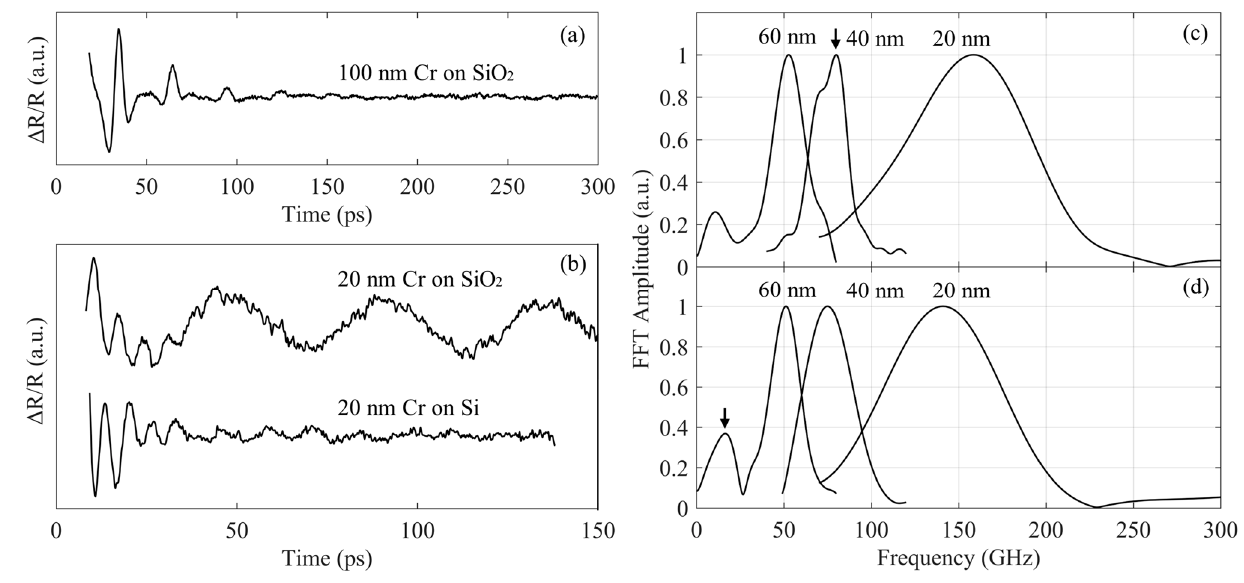
Figure 2. Typical acoustic signals obtained from ( a ) the 100 nm vaporized Cr film and ( b ) 20 nm sputtered Cr films. The Fourier spectra of thin sputtered Cr films on ( c ) Si substrate and ( d ) SiO 2 substrate. Vertical arrows indicate the Brillouin oscillations from the substrates.